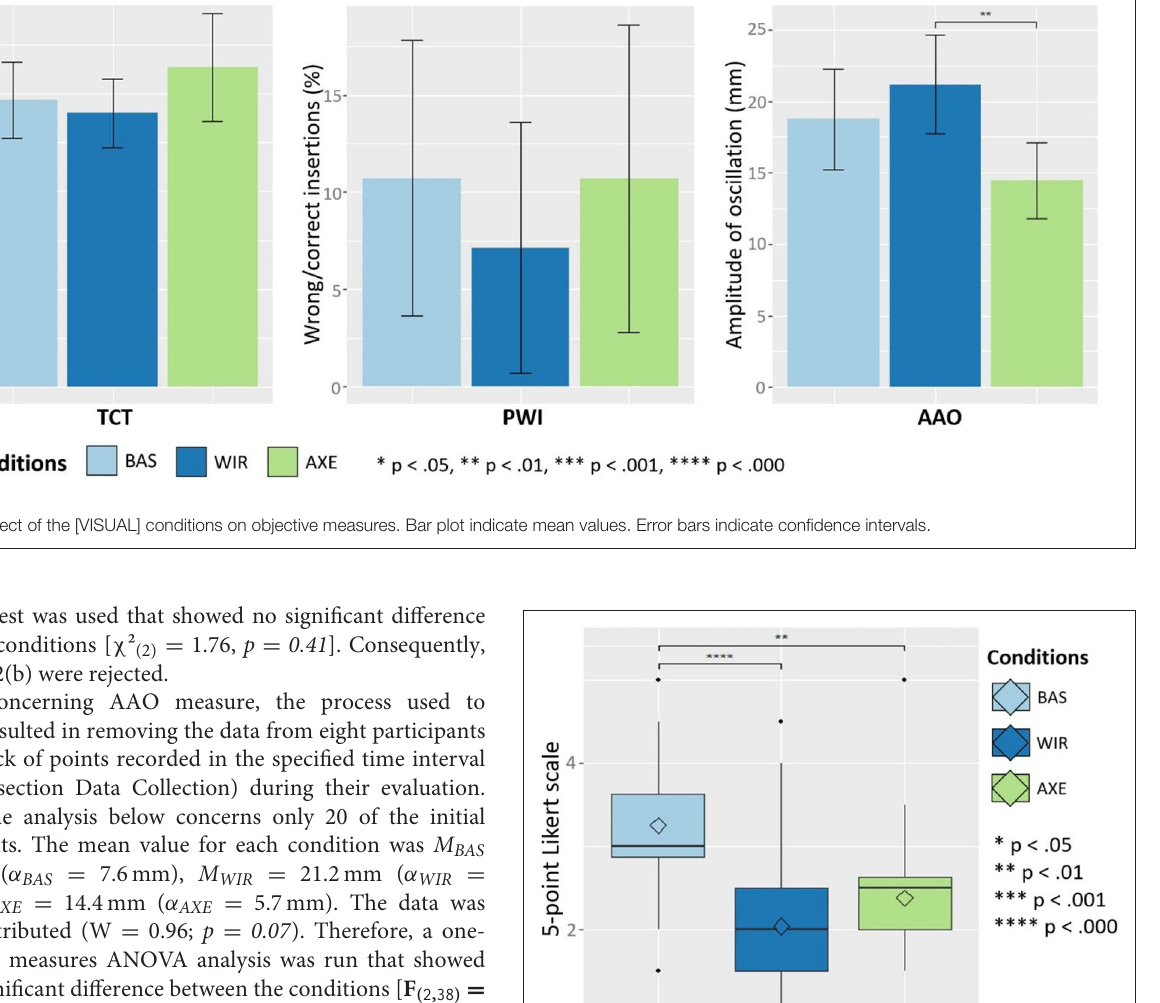
FIGURE 6 | Effect of the [VISUAL] conditions on the difficulty perceived by the participants. The diamond symbol, the line across the box, and the dots represent, respectively, the mean score, the median, and the